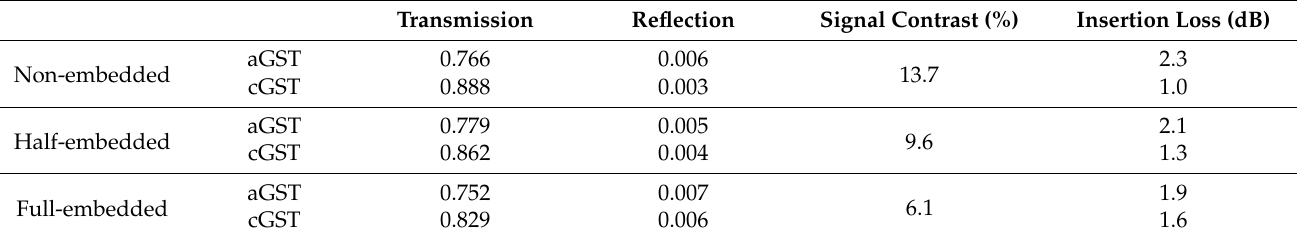
Table 2. Summary of optical properties of the plasmonic phase-change cell at 1550